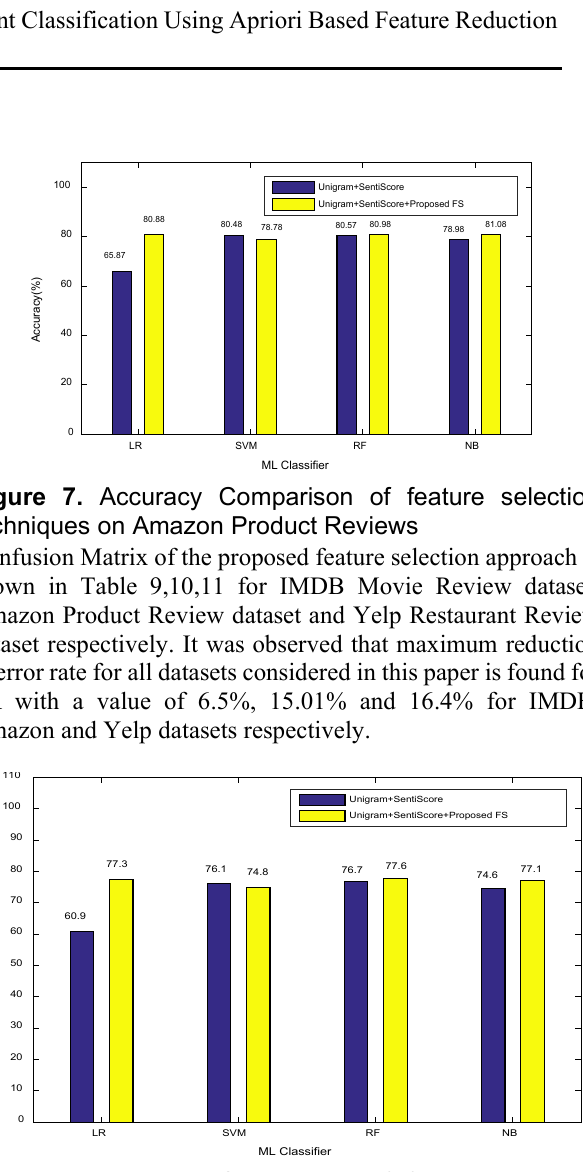
Figure 8. Accuracy Comparison of feature selection techniques on Yelp Restaurant